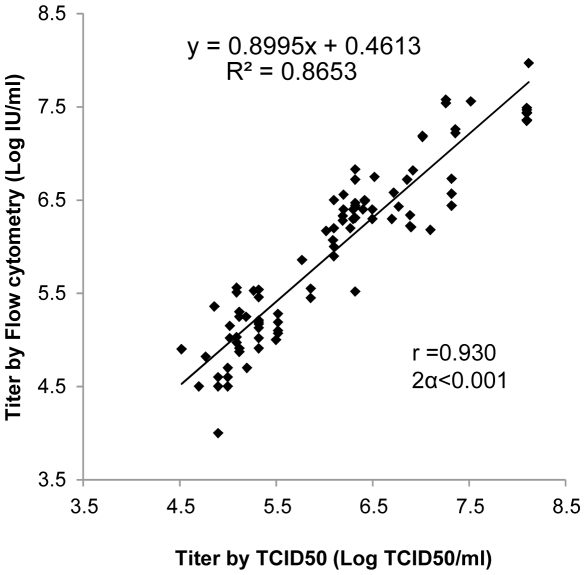
Correlation between titers obtained by the TCID50 technique and the rapid method for titration based on flow cytometry.Ninety five viral stocks from MV strains were titrated by the two techniques with highly correlated values (r = 0,930, 2α<0.001).